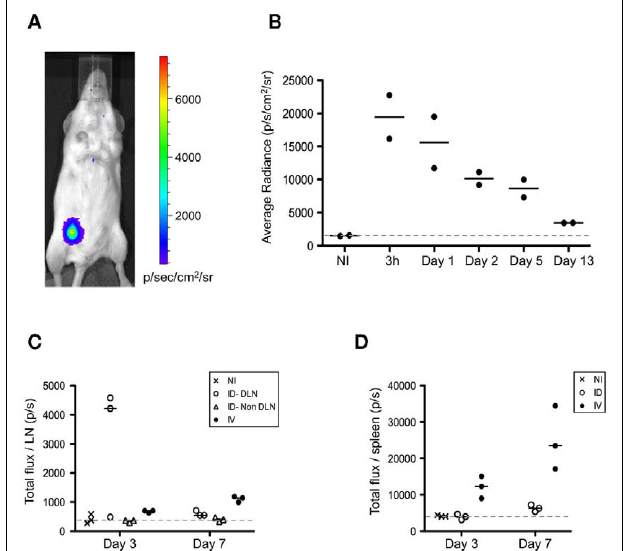
FIGUREA3 | Intradermal injection of splenocytes results in a local depot of donor cells. (A,B) FVB/N female recipients were immunized i.d. or i.v. with 5 × 10 6 FVB/ N -luciferase + male splenocytes. (A,B) Following immunization, mice injected i.d. were evaluated at 3h and then on day 1, 2, 5, and 13. Prior to imaging, mice were injected i.p. with 3mg of D-luciferin (Synchem), followed by isoflurane inhalation to keep animals sedated during analysis. Bioluminescence imaging was performed by using an IVIS Lumina II system (Caliper Life Sciences). Images from mice were acquired over 10min. Quantification of the light emission was analyzed using Living Image Software version 3.1 (Xenogen Corporation), expressed in photons/s/cm 2 /steradian. (A) Representative bioluminescence analysis performed at 3h is shown. (B) Kinetic analysis of the bioluminescent signal is shown. (C,D) On days 3 and 7, the LNs (C) and the spleen (D) from mice immunized i.d. or i.v. were harvested and placed in wells containing PBS and D-luciferin to determine the total bioluminescent signal from each organ.The bioluminescence is expressed as the total flux/organ in photons/s. DLN, draining lymph